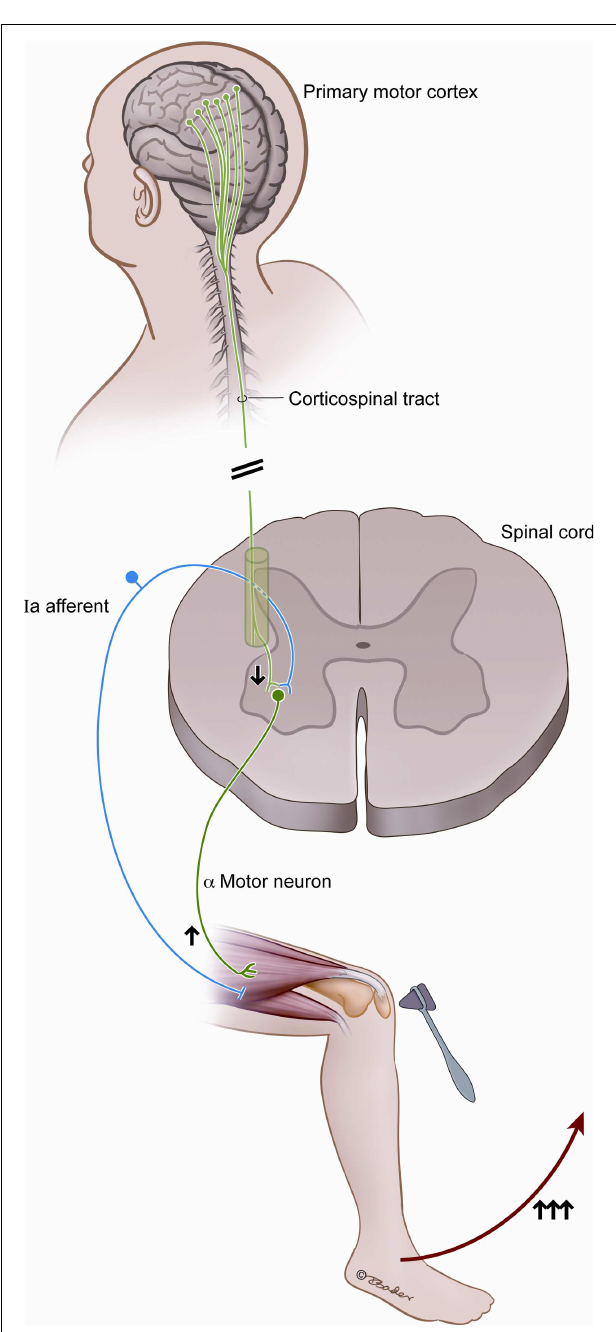
FIGURE 1 |This figure illustrates the classically described spinal reflex arc and the historically described contradictory changes in output resulting from corticospinal tract injury. Arrows indicate the increased alpha motor neuron output as a result of injury to the corticospinal tract, despite the direct connection and stimulatory output from the motor